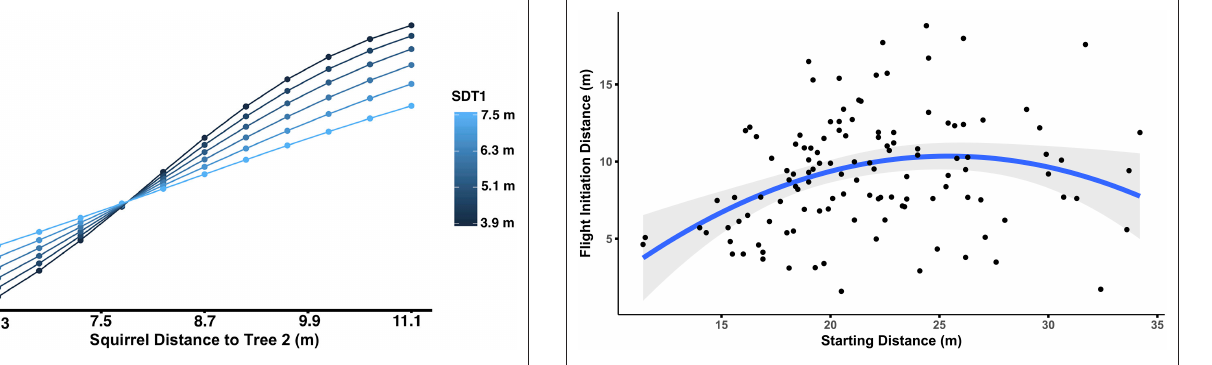
FIGURE 6 | Starting distance has a quadratic relationship with FID. Squirrel FID increases as starting distance increases, but only up to ∼ 25m after which FID declines. Gray area indicates